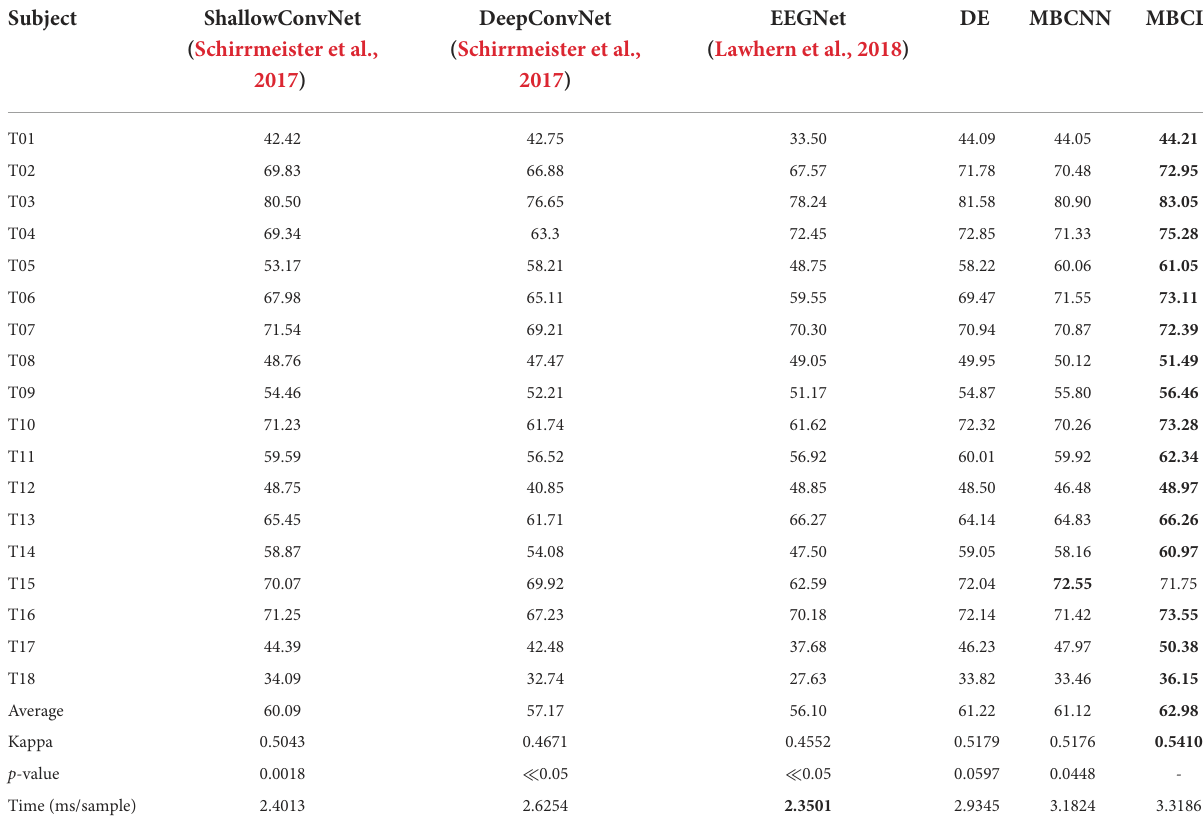
TABLE 2 Performance comparison of different approaches on six MI classes Tohoku University MI-BCI dataset, where highlighted results indicate the best values for each case.